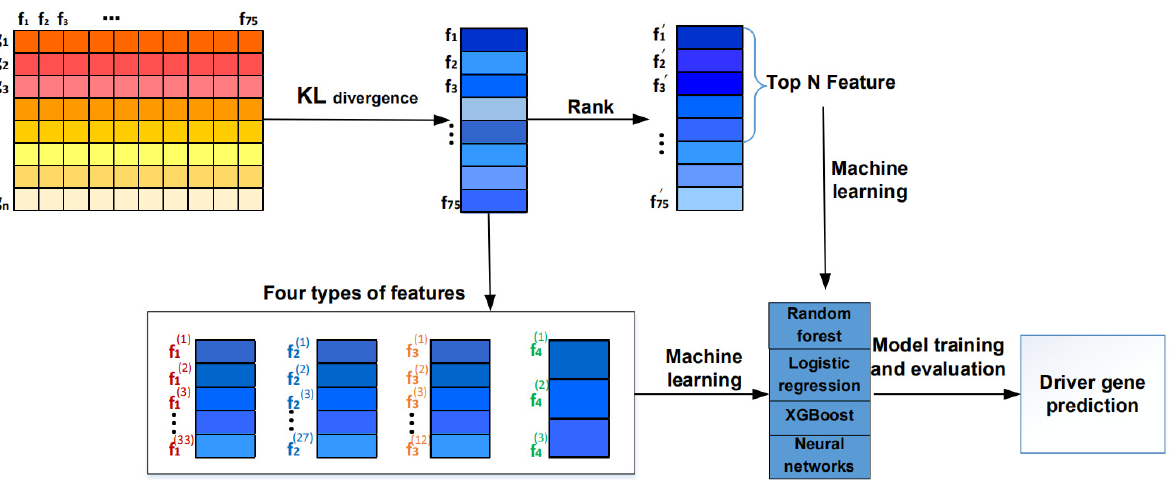
Figure 1. Theframeworkofanalyzingtheinfluenceofmultipleomicsfeaturesondrivergene Figure 1. The framework of analyzing the influence of multiple omics features on driver gene iden- tification.